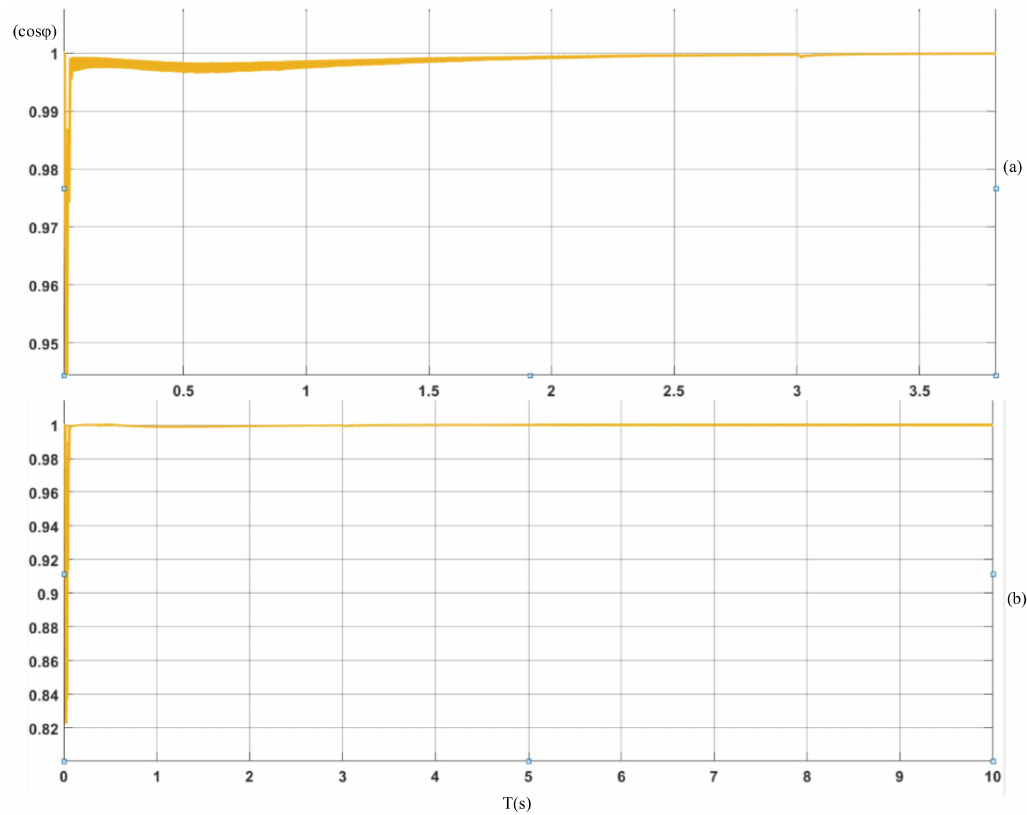
Figure 20. Power factor of AC input side: ( a ) controlled by the direct power control method; ( b ) controlled by the nonlinear feed-forward PID control